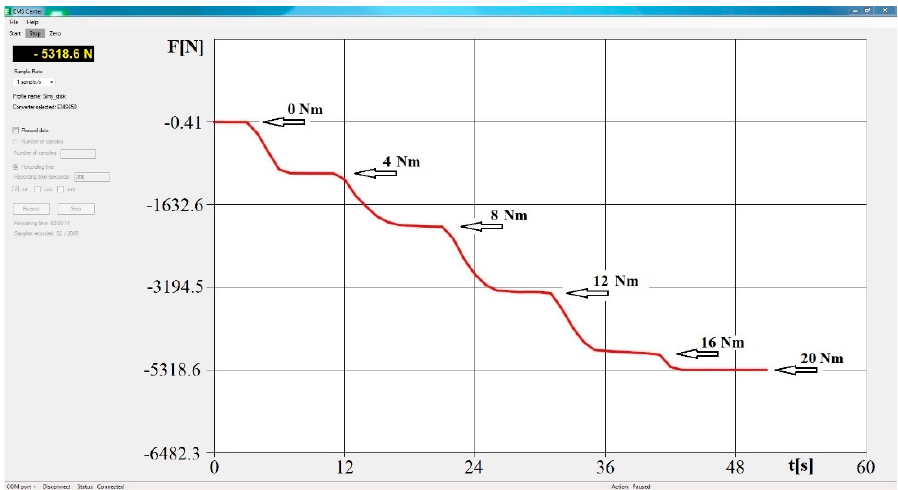
Table 4. Values determined via measurement with lubricant CX80—copper grease.